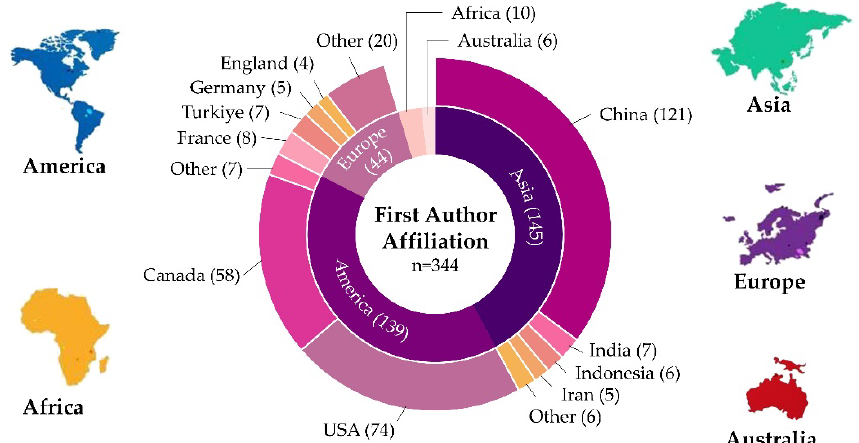
Figure 8. Country and continent-based overview of first author affiliations. Among the continents, Asia (with 42%), America (with 40%), and Europe (with 13%) hold the largest shares, and among countries, China (with 35%), the USA (with 21%), and Canada (with 17%) hold the largest shares.